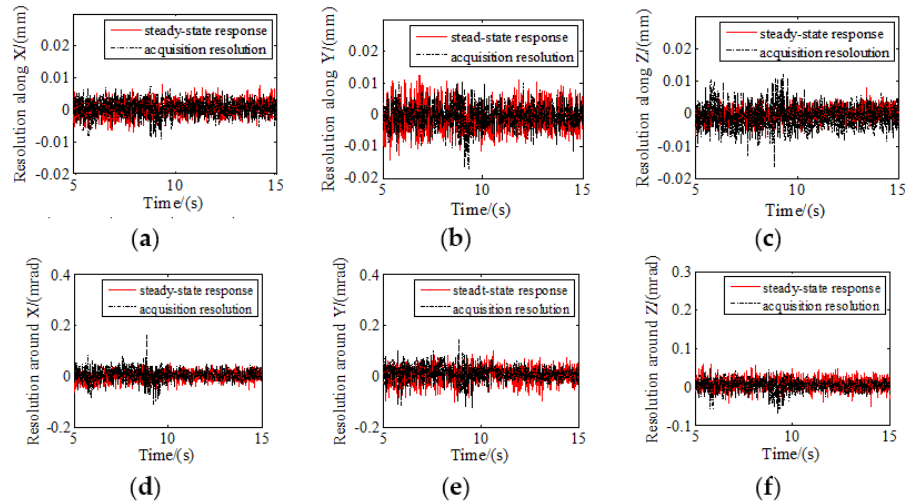
Figure 10. Resolution comparison of relative position and attitude with six DOFs: ( a ) Resolution along X ; ( b ) resolution along Y ; ( c ) resolution along Z ; ( d ) resolution around X ; ( e ) resolution around Y ; ( f ) resolution around Z .